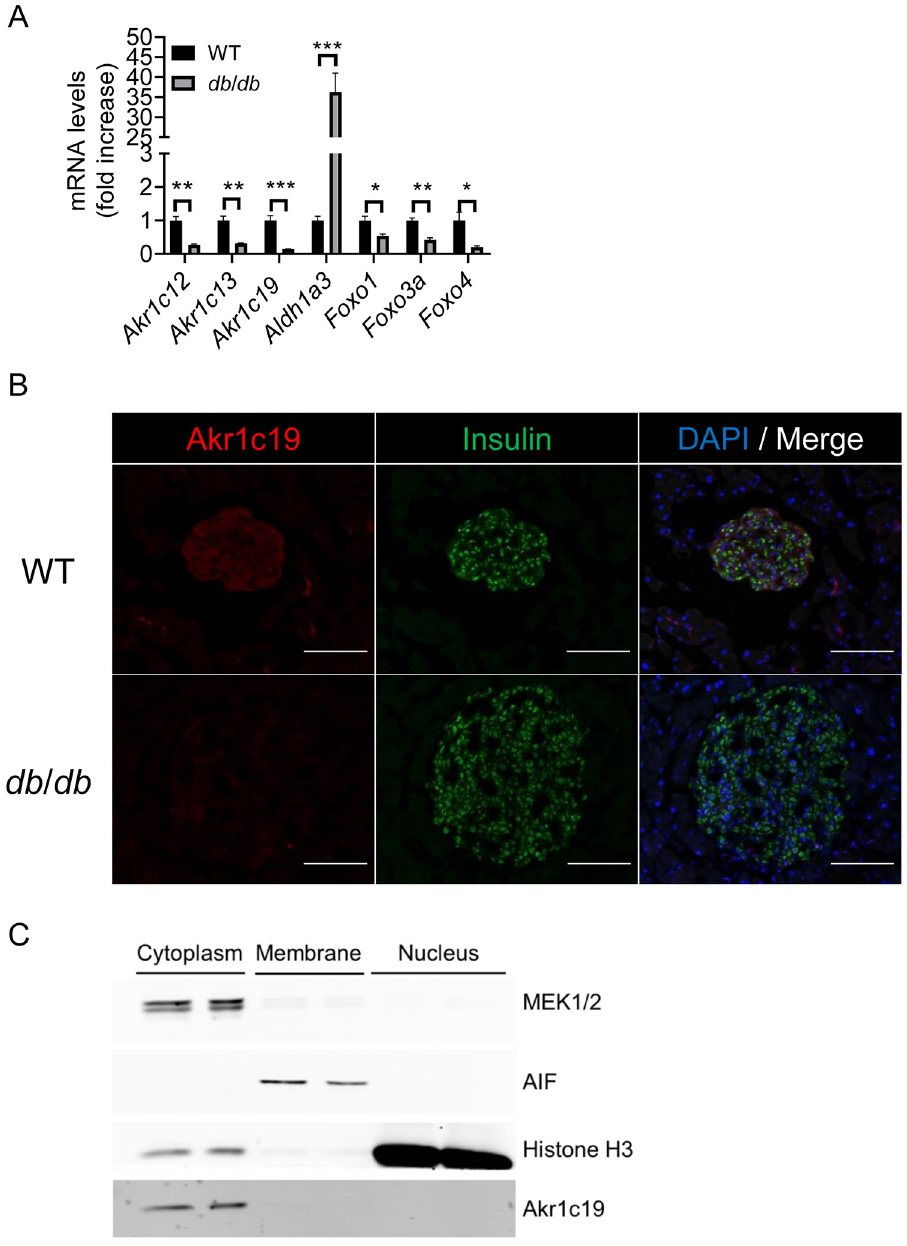
Fig 2. Akr1c19 expression in db / db islets and localization in MIN6 cells. (A) Gene expression analysis in islets from 12-week-old WT and db / db male mice (n = 4, each group). (B) Immunostaining for Akr1c19 (red), insulin (green), and DAPI (blue) in islets from WT (upper) and db / db (lower). Scale bar = 100 μ m. (C) Immunoblotting for Akr1c19 in subcellular fractions of MIN6 cells. All values represent mean ± SEM. � p < 0.05, �� p < 0.01, ��� p < 0.001 by Student’s